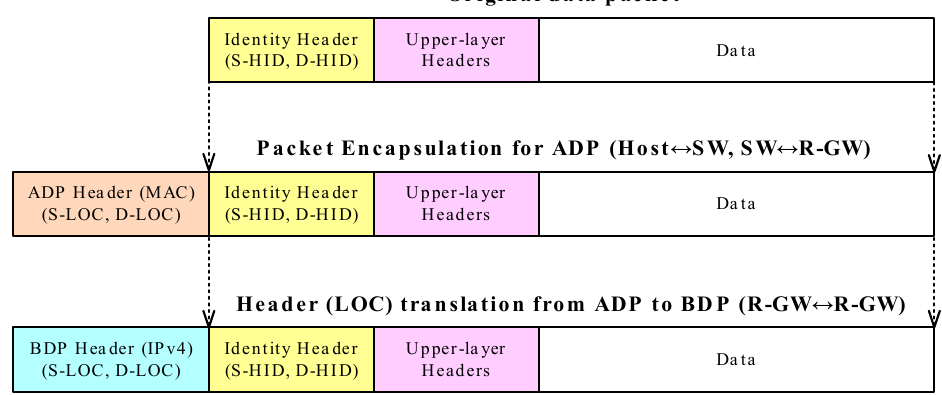
Figure 10. Structure of data packets.